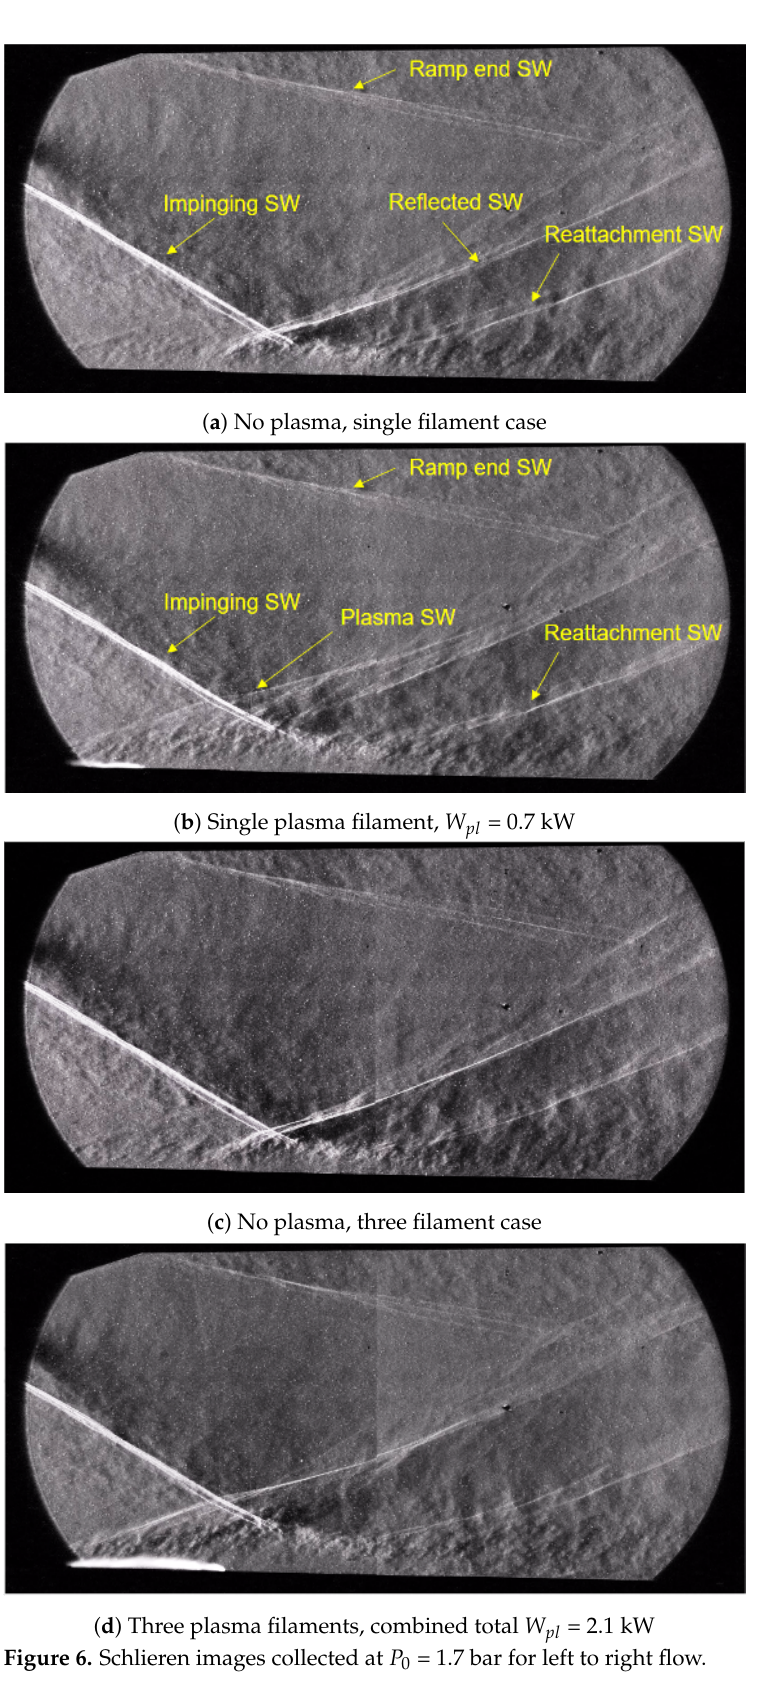
Figure 6. Schlieren images collected at P 0 = 1.7 bar for left to right